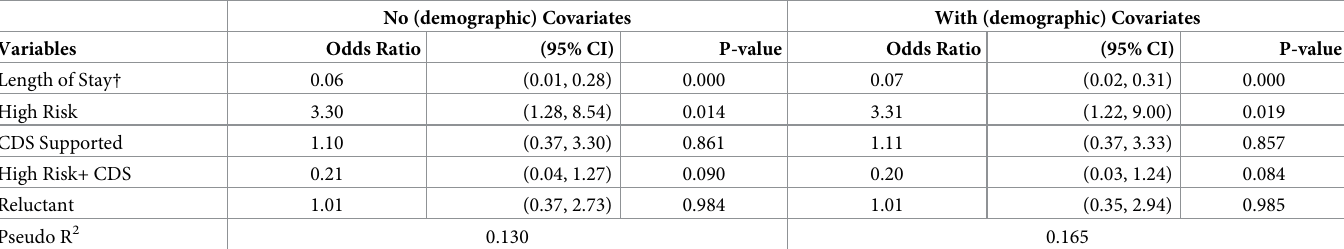
Table 2. Multivariable logistic regressions of readmission risk on decision-support availability, degree of readmission risk, and patient preference for